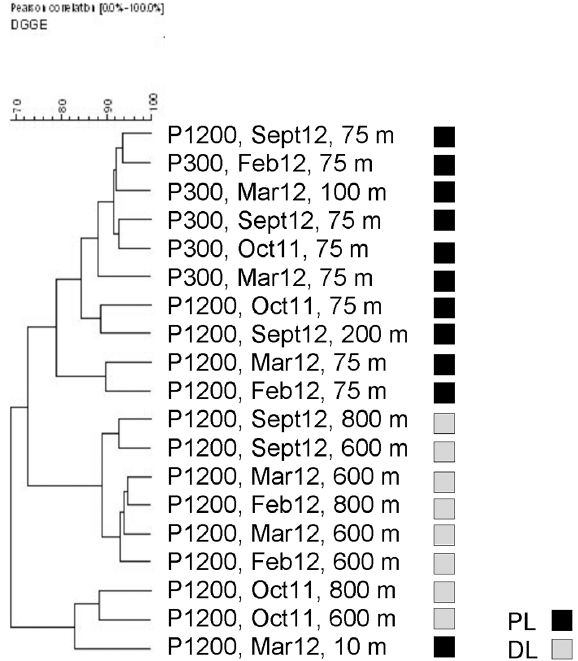
Figure 8. Cluster analysis dendrogram of DGGE banding pattern (Gel Compare, v. 4.1, Applied Maths, Kortrijk, Belgium) performed calculating the Pearson correlation similarity coefficient for bacte- rial communities sampled in the productive and deeper layers (Oc- tober 2011–September 2012).